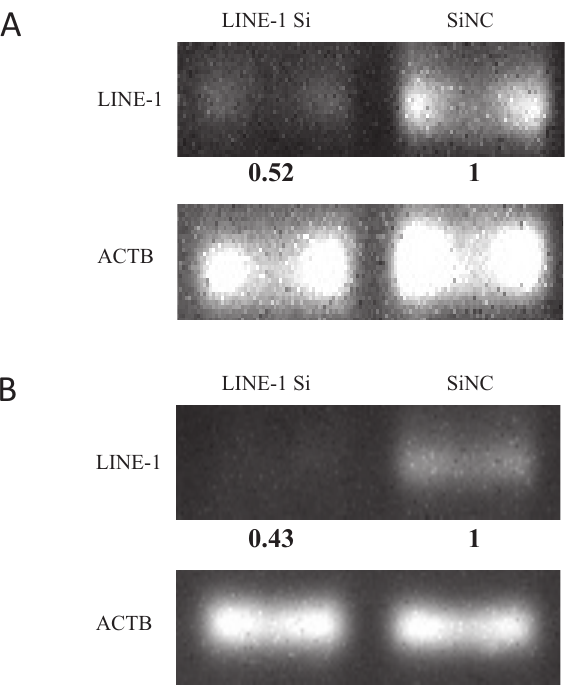
F i g ure 2 LINE-1 mRNA expression in ( A ) Caco-2 and ( B ) S W 480 cells is s u ppressed b y RNA interference. Northern blot anal y sis of LINE-1 mRNA are sho w n in the u pper panel w ith n u m- bers reflectin g the relati v e amo u nt of LINE-1 mRNA q u antified b y ima g e anal y sis soft w are, Ima g eJ, and normalized to β -actin. Northern blot anal y sis of β -actin mRNA are sho w n in the lo w er panel. LINE-1 Si is a LINE-1-specific 23-mer do u ble-stranded RNA for RNA interference and SiNC is a non-specific seq u